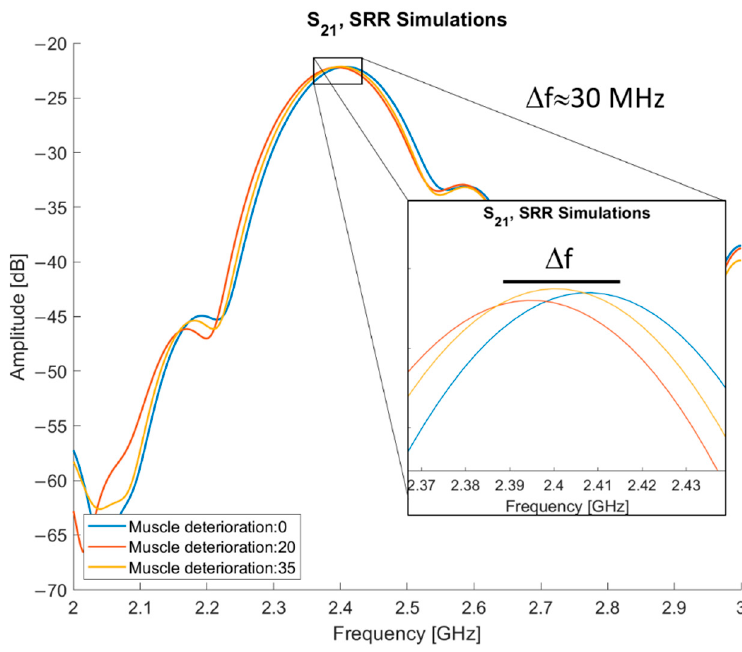
Figure 11. S 21 of simulations with normal and deteriorated muscle tissue.